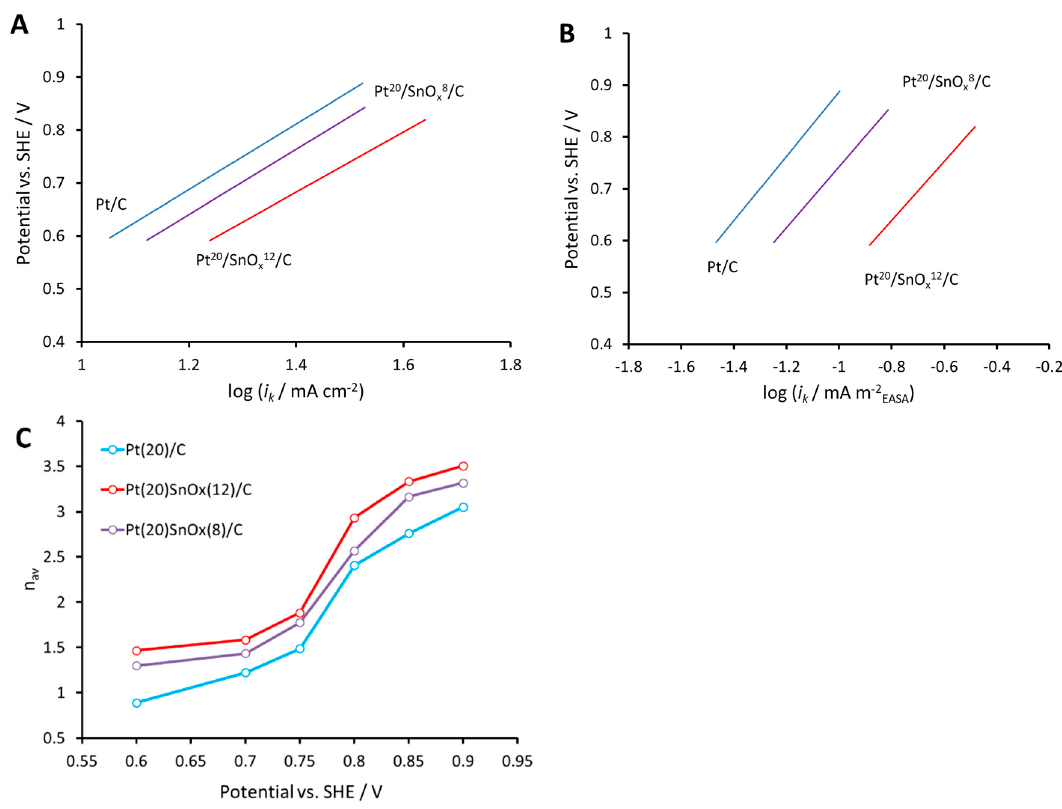
Figure 7. ( A , B ) Tafel plots of different catalysts plotted using the kinetic currents obtained from Koutecky–Levich plots, and ( C ) the average number of transferred electrons calculated through Equation (4).